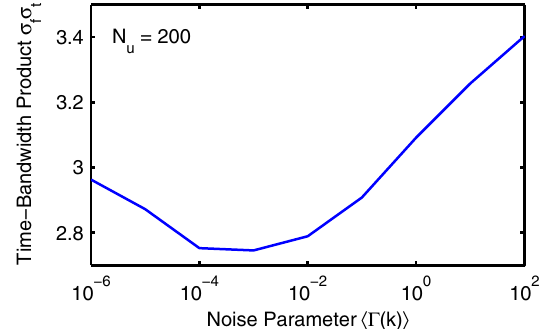
FIG. 10. The time-bandwidth product vs noise parameter. The result is statistically averaged.